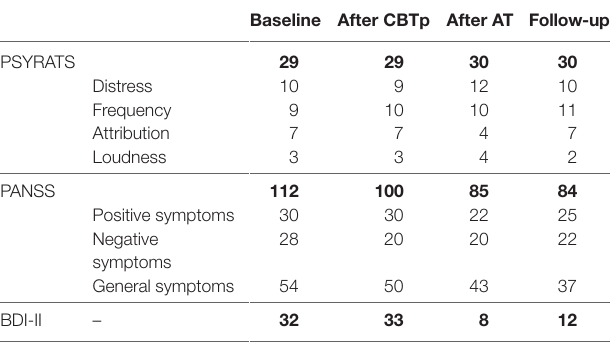
tabLe 3 | Changes in psychiatric symptoms following cognitive-behavioral therapy for psychosis (CBTp) and avatar therapy (AT). baseline after Cbtp after at